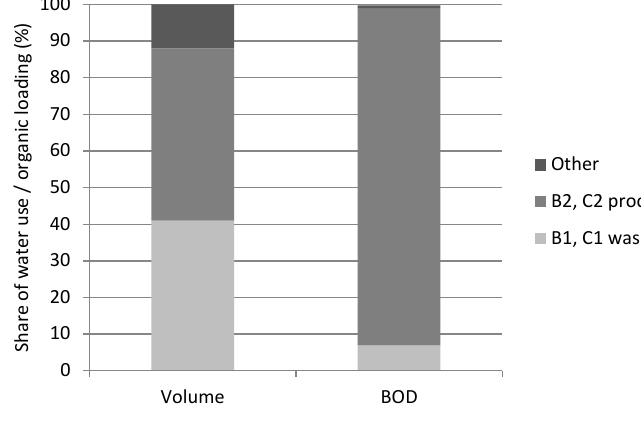
Fig. 3. Division of the mean volumes and mean BOD of wastewaters in two 7 vegetable processing plants (B, C). Washing = water used for cleaning the vegetables before processing; processing = water usage in the processing phase. Other = water used for cleaning the premises and other occasional